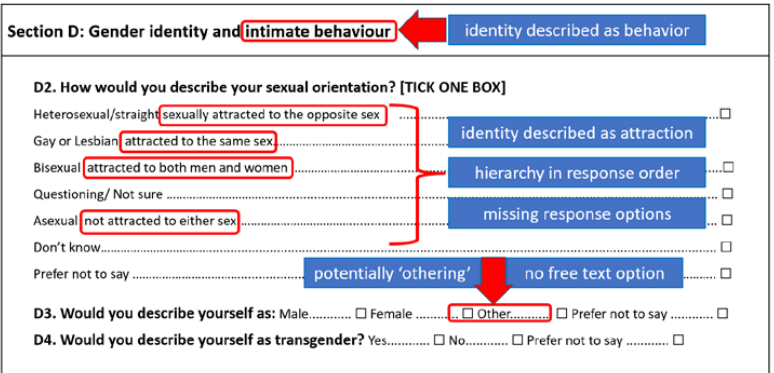
Figure 4. PPI Panel members’ observations on issues with SOGI phrasing in GUI.